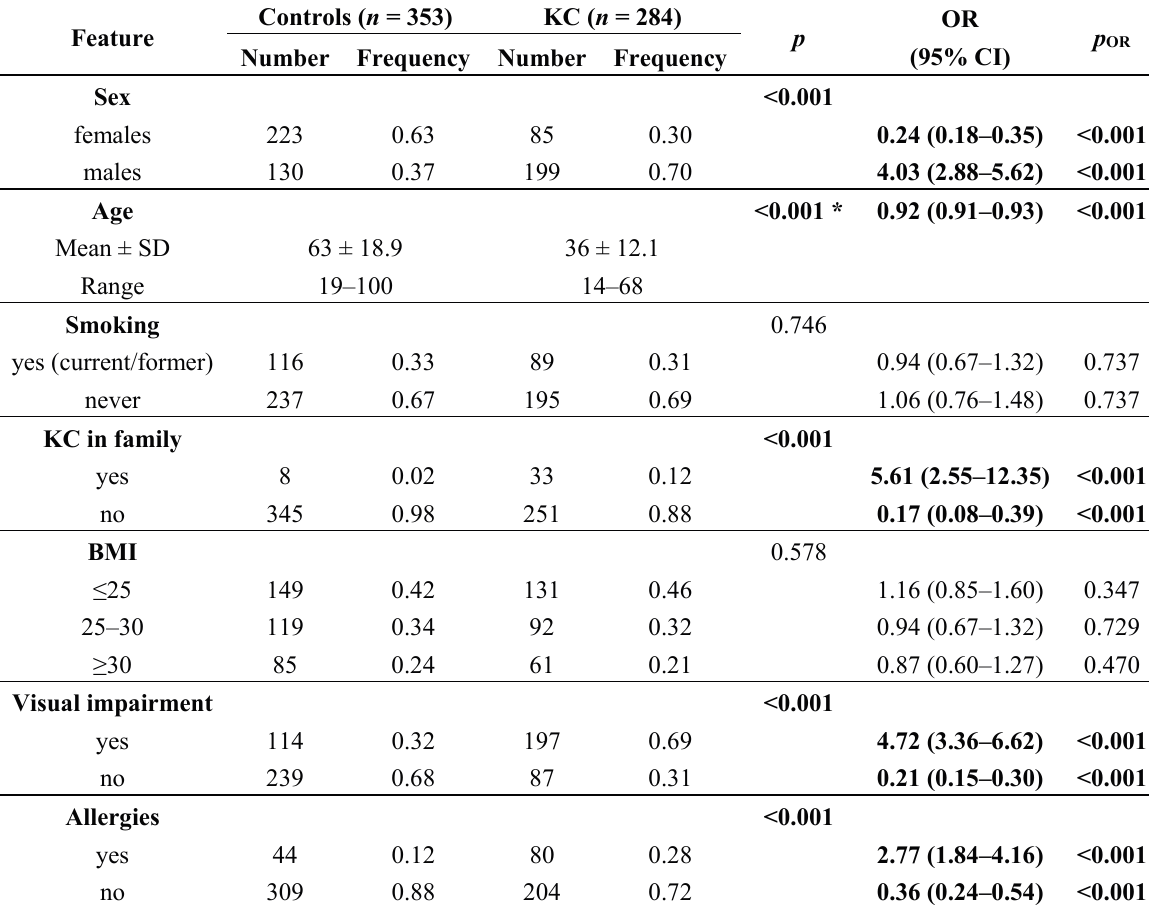
Table 1. Risk of keratoconus (KC) associated with age, sex, tobacco smoking, co-occurrence of visual disturbances, body mass index (BMI), allergies and family history of